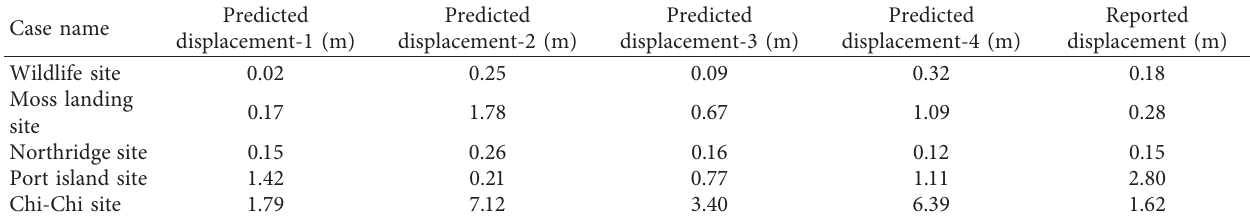
Table 11: Predicted lateral spreading and the reported